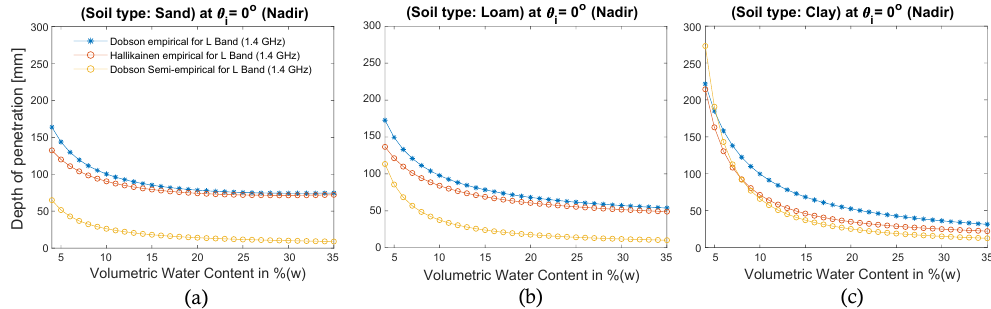
Figure 3. Penetration depth (mm) of SAR pulses (L-band) as a function of volumetric water content (in %) at nadir in different soil types: ( a ) sandy, ( b ) loamy, and ( c ) clayey.